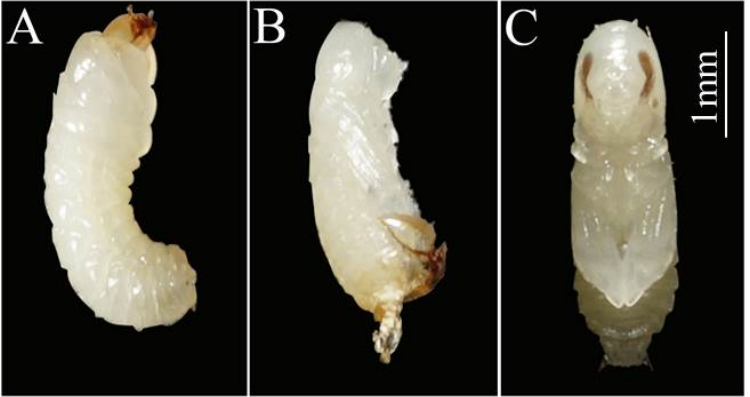
Figure 2. Morphological changes of Acanthotomicus suncei from larva to pupa; ( A ) mature larva; ( B ) callow pupa (the shell shed to the bottom); ( C ) mature pupa with the black eyes gradually developed.